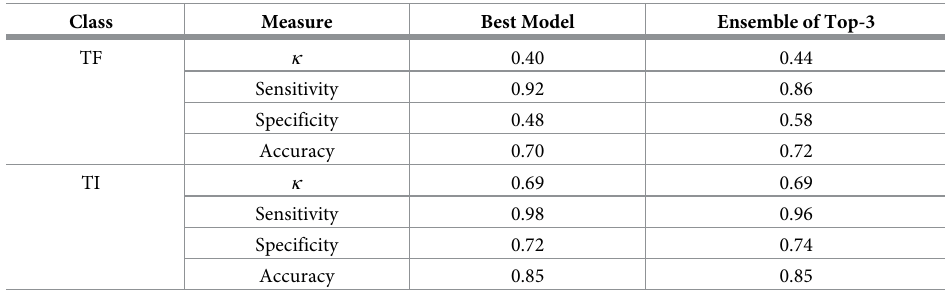
Table 3. Validation scores on trained convolutional neural network models for TF and TI classification tasks.